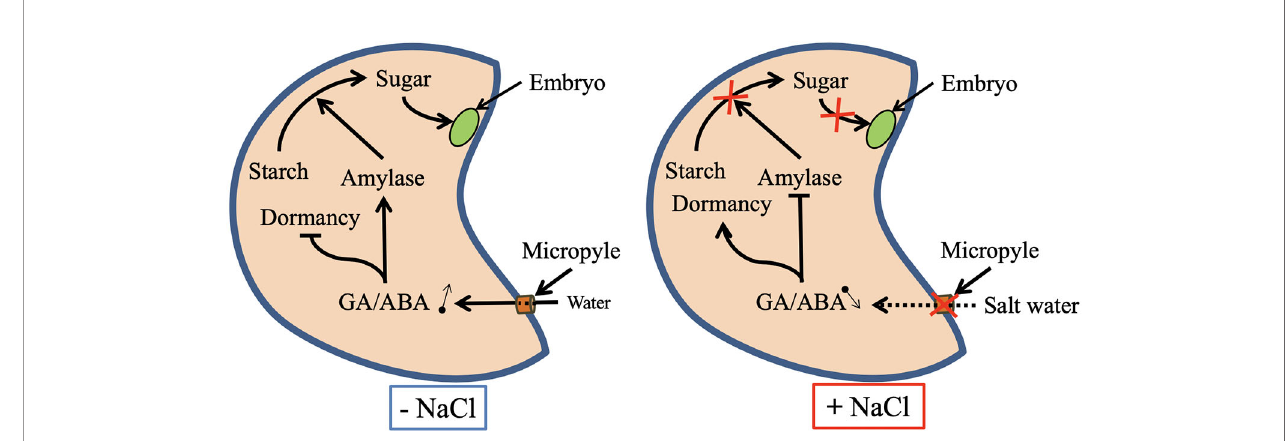
FIGURE 1 | Proposed mechanisms for the regulation of seed dormancy release and seed reserve mobilization under salt-stressed and unstressed conditions. Abbreviations: ABA, abscisic acid; GA, gibberellic acid.